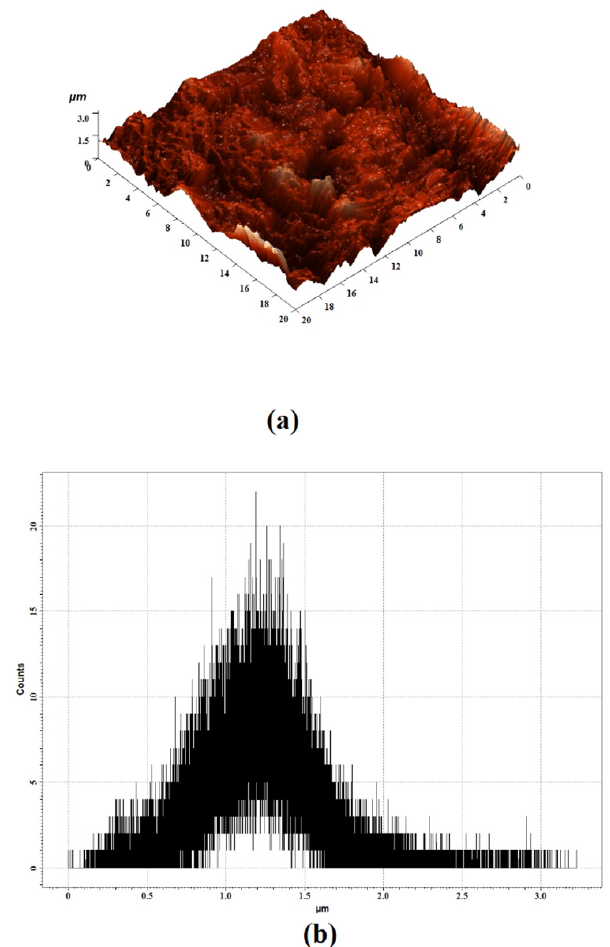
Figure 6. Surface morphology analysis of machined specimen under optimal process factors: ( a ) Three-dimensional view and ( b ) Histogram analysis.